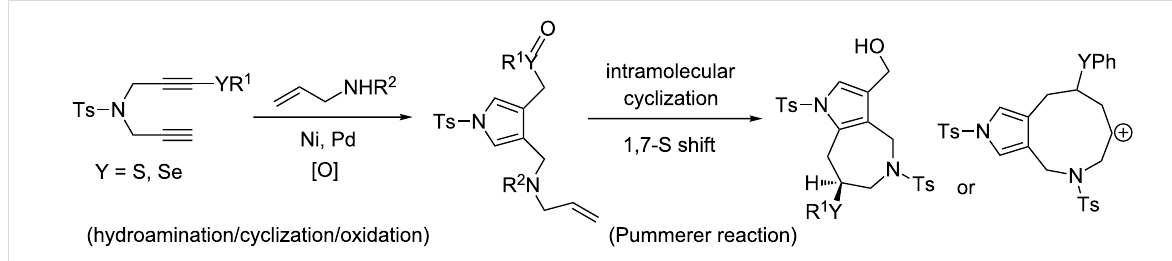
Scheme 1: Our synthetic plan for pyrrolo[3,2- c ]azepines.